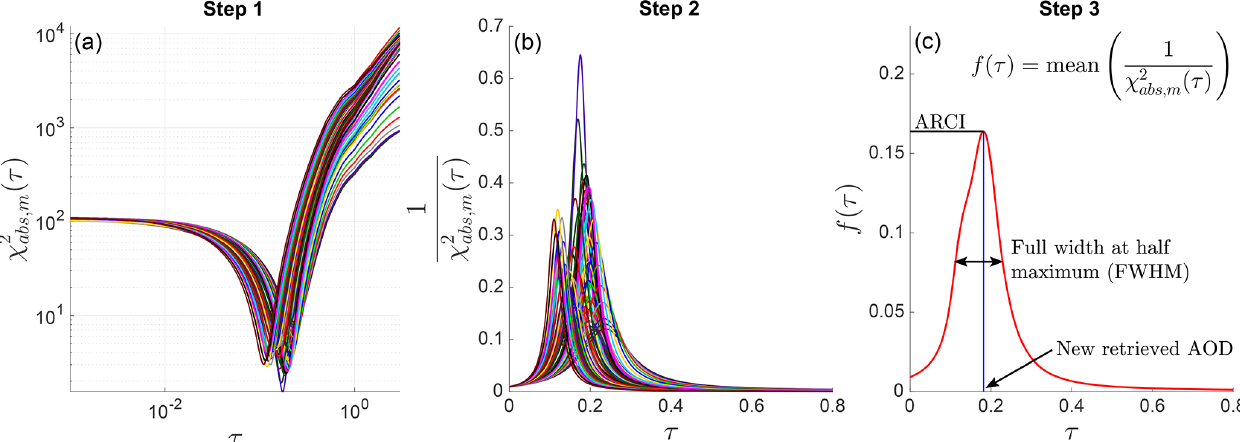
Figure 1. Example of calculation steps performed in the new methodology for determining AOD and its uncertainty. (a) χ 2 MISR mixtures as a function of AOD ( τ ) (Eq. 1); (b) inverse (reciprocal) values for the 74 mixtures; and (c) inverse residuals averaged over all mixtures (Eq. 2), with the new retrieved AOD, ARCI, and FWHM indicated on the distribution. The x -axis scale is logarithmic in panel (a) for a better visualization of the cost function at low τ .